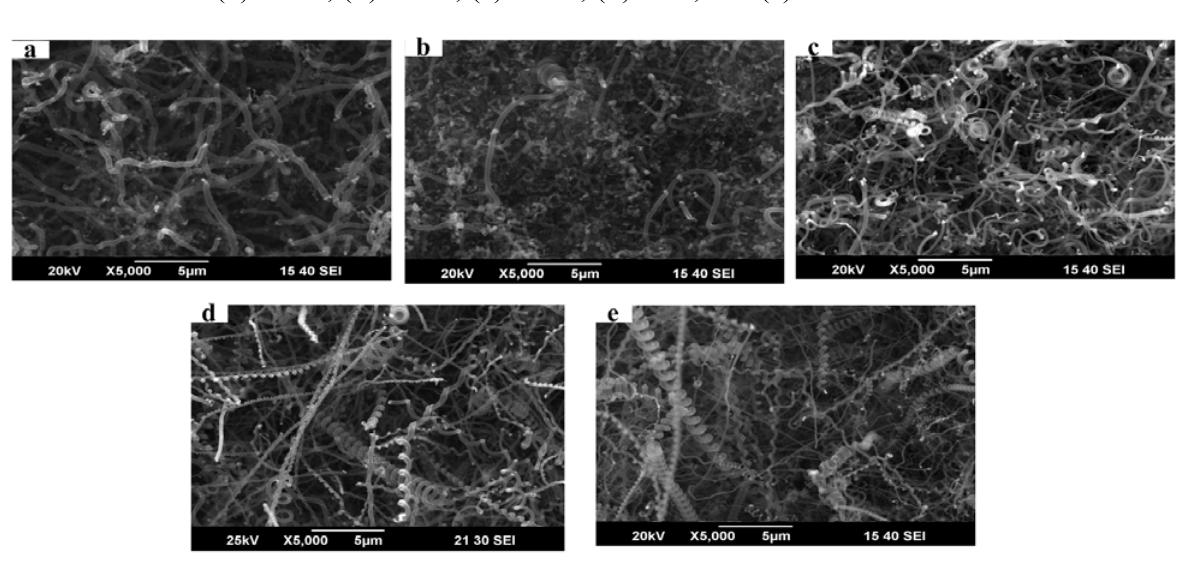
Figure 2. SEM images of the as-grown CMCs/CNFs from Fe-Sn powder catalyst at